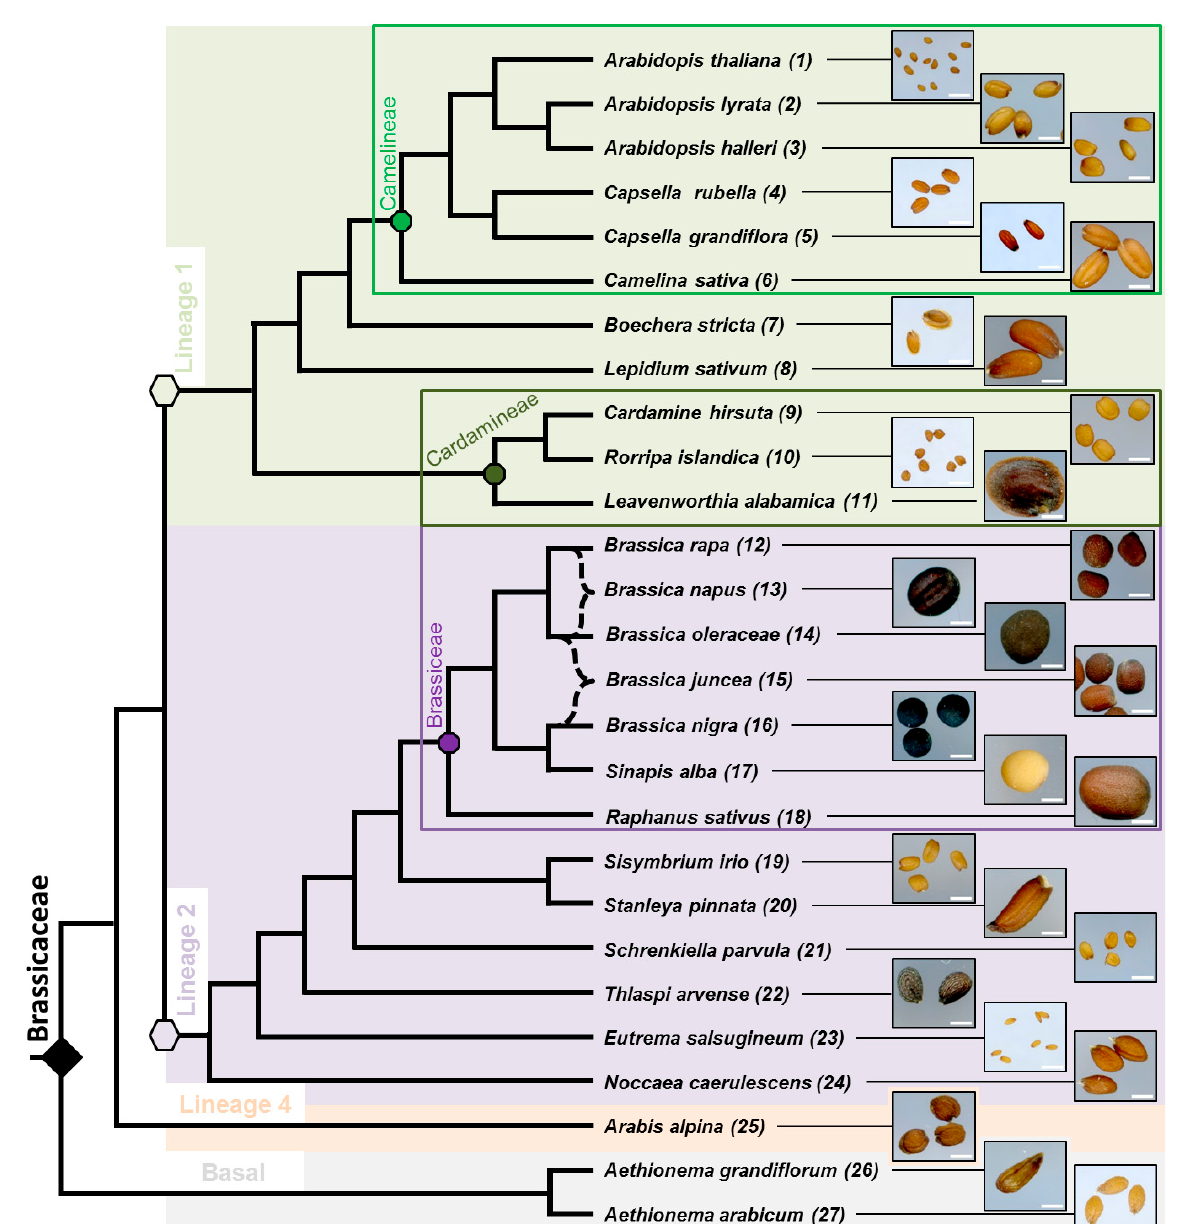
Figure 1. Simplified phylogenetic tree of the 27 phenotyped Brassicaceae species and illustration of their dry seed phenotype. Phylogenetic relationships between species are based on [28–30]. For sake of clarity, the species names were each associated with a number used to facilitate their identification along the manuscript. Lineages are highlighted by different background colors and the three tribes containing more than one species are labeled by colored rectangles. Note the high diversity of dry seed size and morphology observed with high resolution scanning. Scale bar: 1 mm.